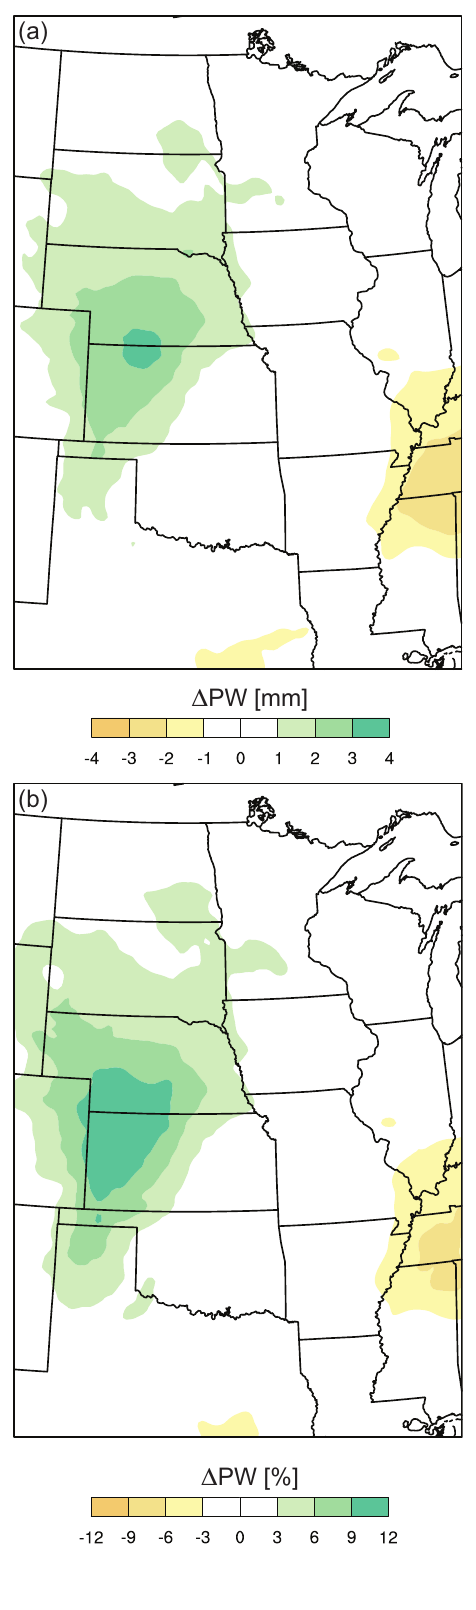
Figure 10. Differences in monthly-mean precipitable water (PW) between the IRR and CTL simulations for the month of July. ( a ) Absolute difference (mm); ( b ) Relative difference